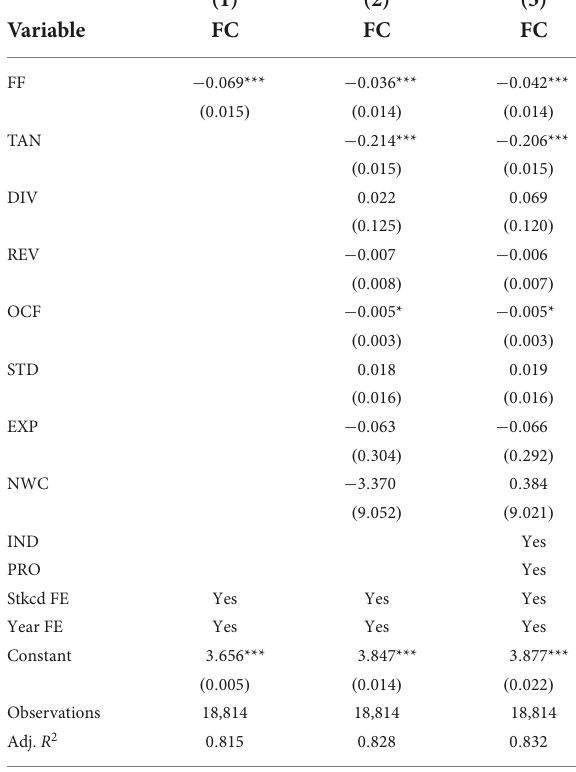
TABLE 4 Multiple regression analysis of financial flexibility and financing